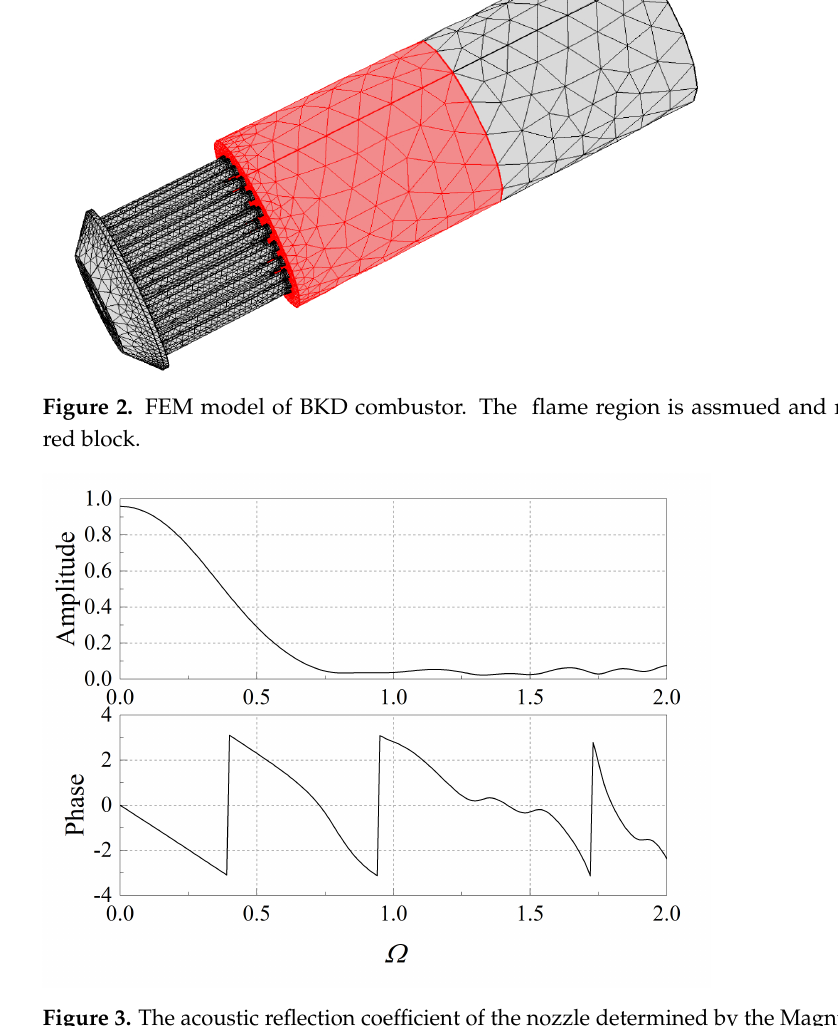
Figure 3. The acoustic reflection coefficient of the nozzle determined by the Magnus expansion of the linearised Euler equations of the nozzle.